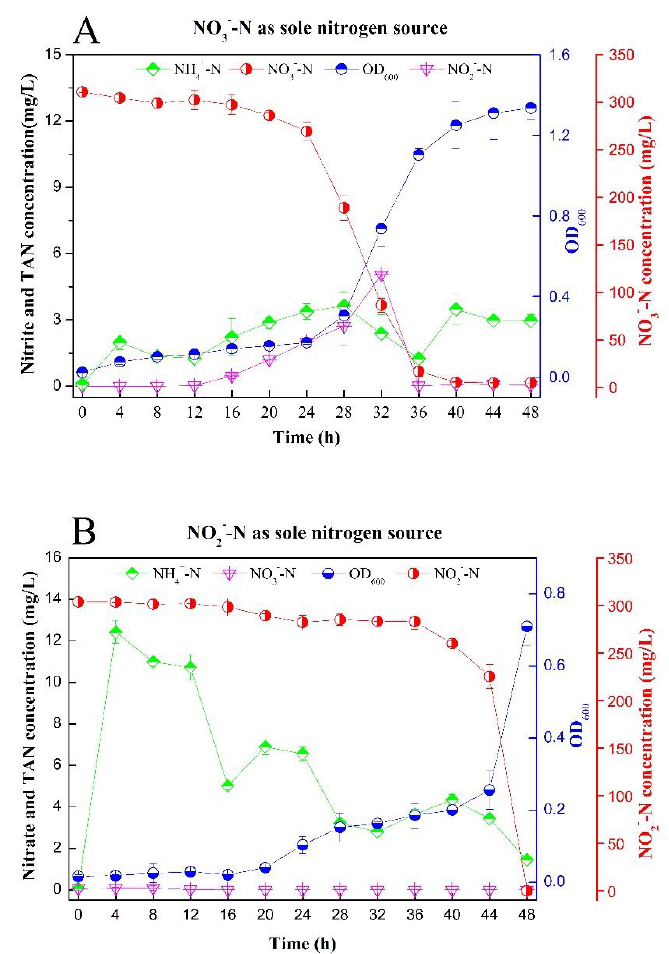
Figure 2. Aerobic nitrogen-removal characteristics and cell growth of strain RAD-2 in denitrification media (DM). ( A ) Nitrate as the sole nitrogen source; and ( B ) nitrite as the sole nitrogen source. Data shown are mean ± SD (error bars) from three replicates.